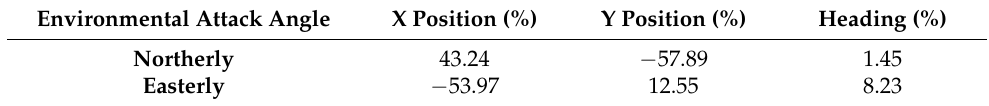
Table 6. Position and heading accuracy improvement